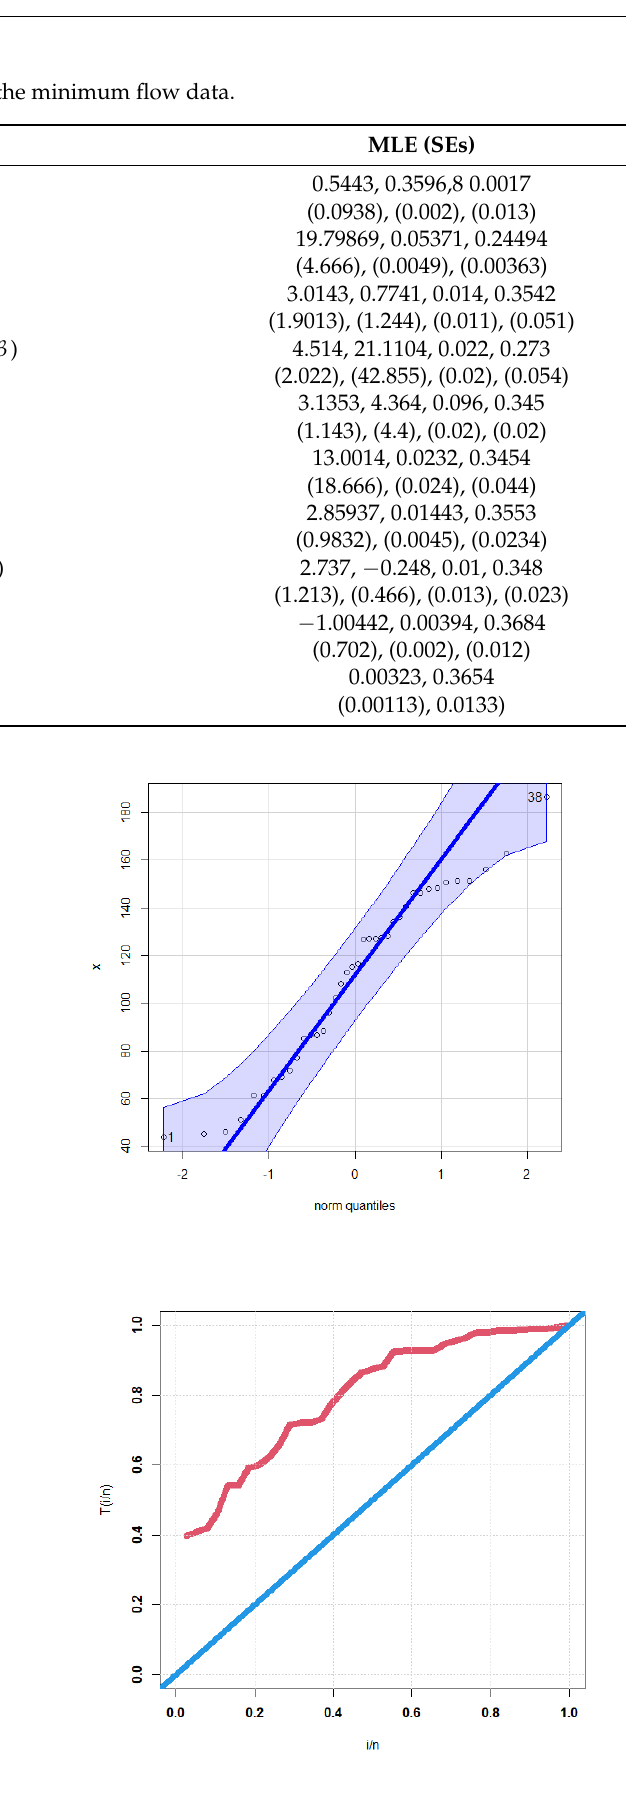
Table 4. The MLEs and SEs for the minimum flow data.